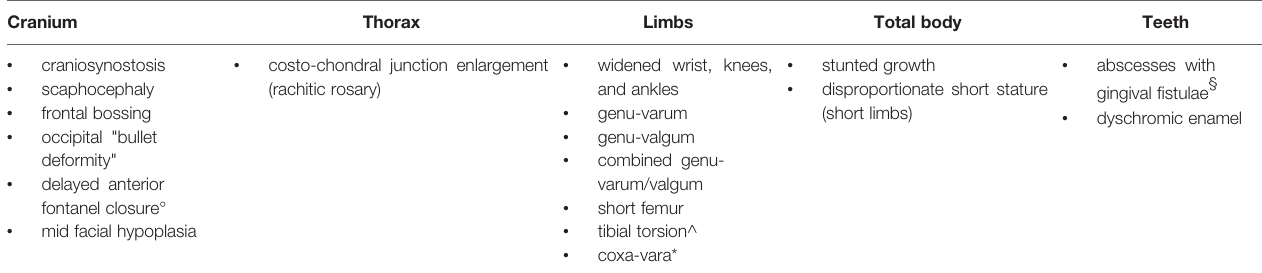
TABLE 1 | Main skeletal and dental-periodontal lesions in patients with XLH. Cranium Thorax Limbs Total body